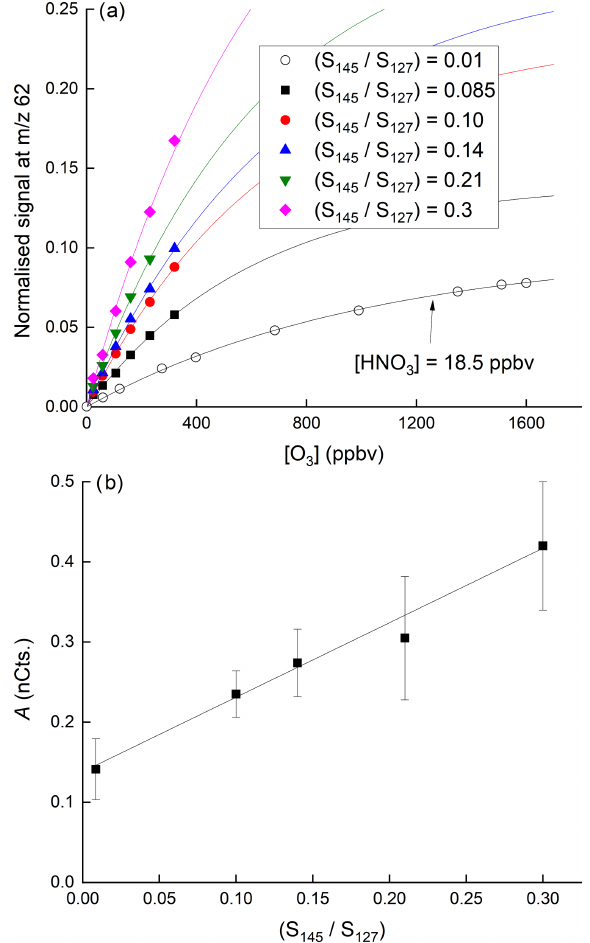
Figure 7. (a) Dependence of the signal at m/z 62 on the O 3 mix- ing ratio for six different concentrations of H 2 O in the IMR. In the upper five curves (solid symbols) the HNO 3 mixing ratio was 38.5ppbv. In the lowermost curve, the HNO 3 mixing ratio was 18.5ppbv, as indicated. The fits lines are of the following form: y = A ∗ exp ( 1 − exp ( − B ∗[ O 3 ] )) . (b) Plot of parameter A versus the relative signal at m/z 145 and m/z